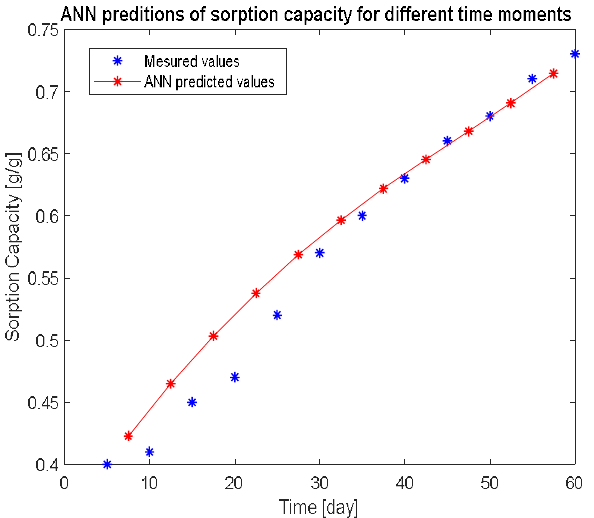
Figure 8. ANN predictions of the sorption capacity at different time intervals for shungite and rice husk at a ratio of 6:1 and for the 15% oil-contaminated soil .